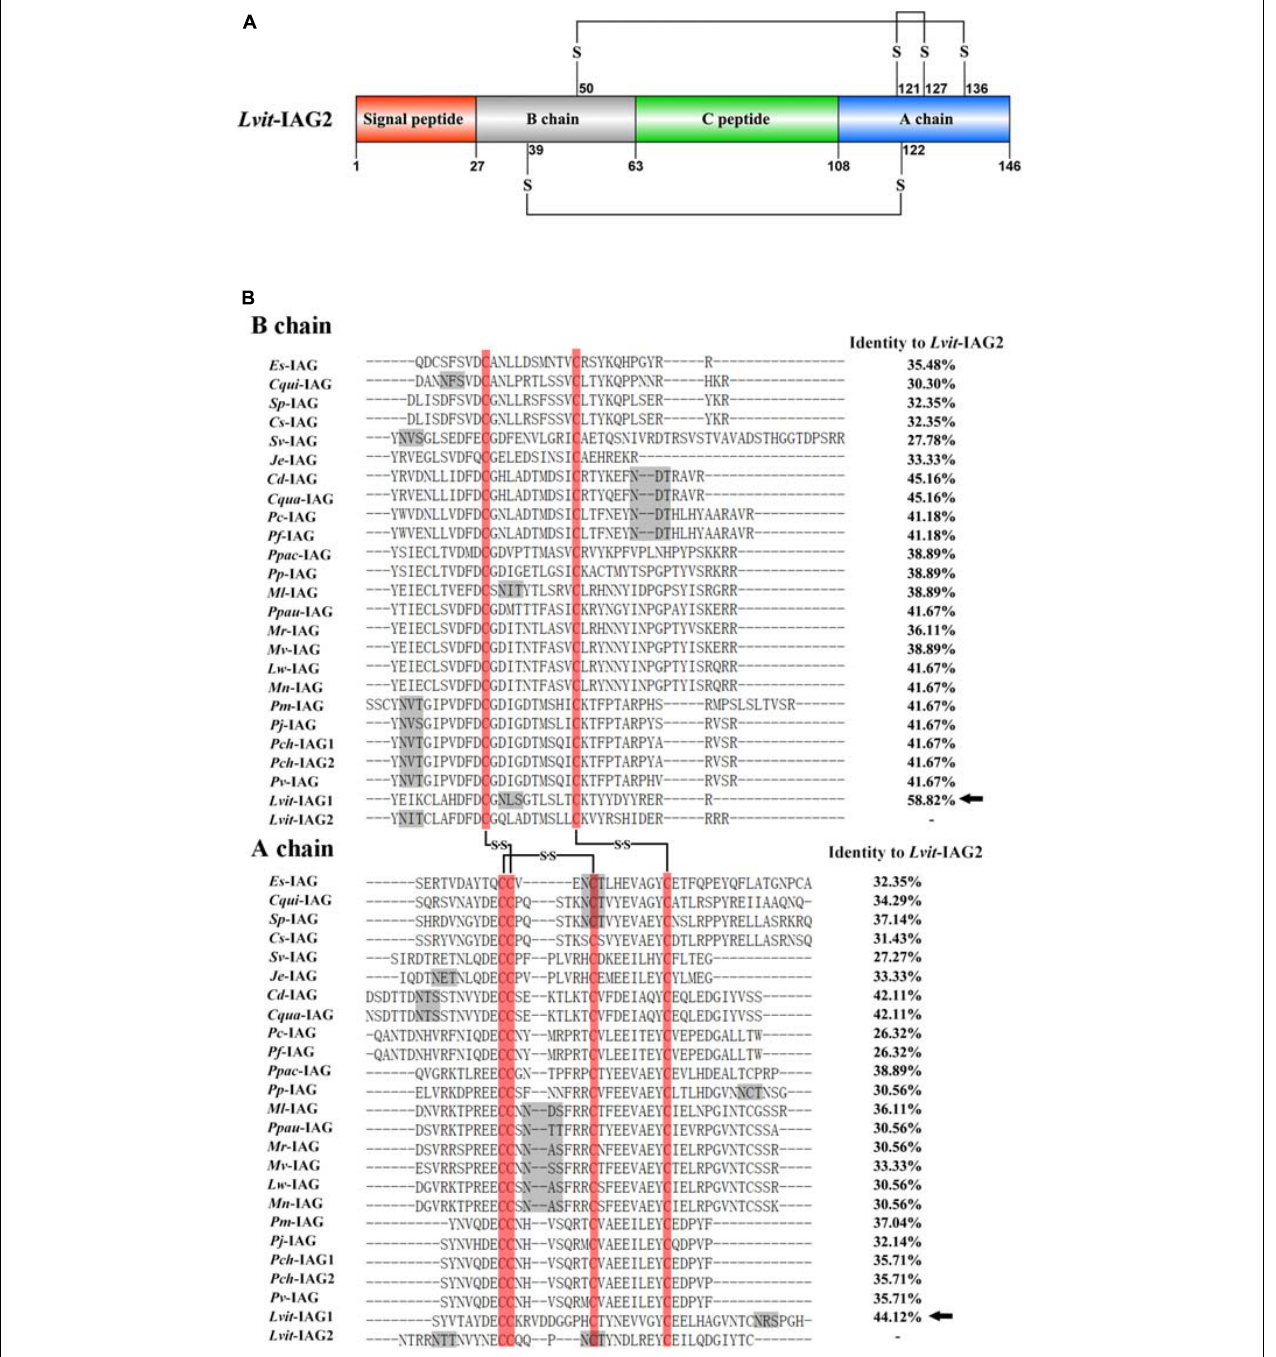
FIGURE 1 | Sequence analysis of Lvit -IAG2. (A) Schematic diagram of preproprotein of Lvit -IAG2 containing a signal peptide, B chain, C peptide, and A chain. The six cysteine residues of B chain and A chain were predicted to form three putative disulfide bridges connected with lines. (B) Multiple sequence alignment of putative B chain and A chain of decapod IAGs. The sequence information was given in Table 2 . Six conserved cysteine residues were boxed in red, and three putative disulfide bridges were connected with lines. Predicted N-glycosylation sites were marked by gray shadow. Lvit -IAG1 was marked with solid arrows.